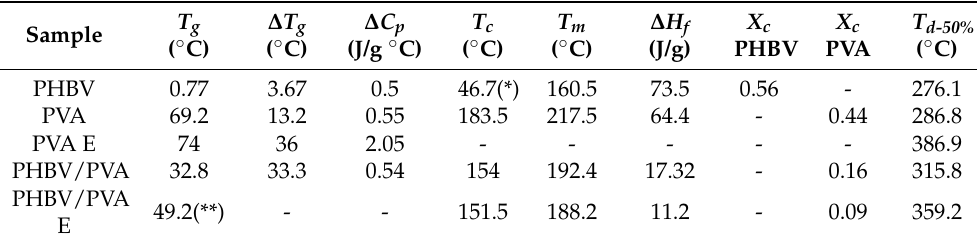
Table 3. Glass transition temperature ( T g ), width of the glass transition ( ∆ T g ), heat capacity increment at the glass transition (∆ C p ), crystallization ( T c ) and melting ( T m ) temperature, enthalpy of fusion (Δ H f ), degree of crystallinity PHBV ( X c PHBV ) and PVA ( X c PVA ) and 50% weight loss decomposition temperature ( T d-50% ) for neat PHBV and PVA, crosslinked PVA, PHBV/PVA blend and semi-IPN PHBV/PVA.